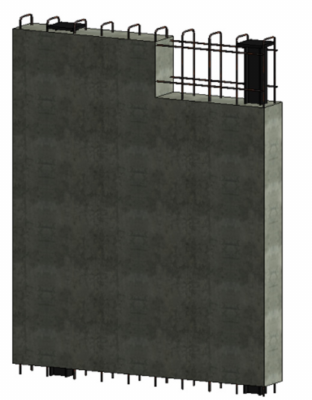
Figure 2. Schematic of the prefabricated wall stem.